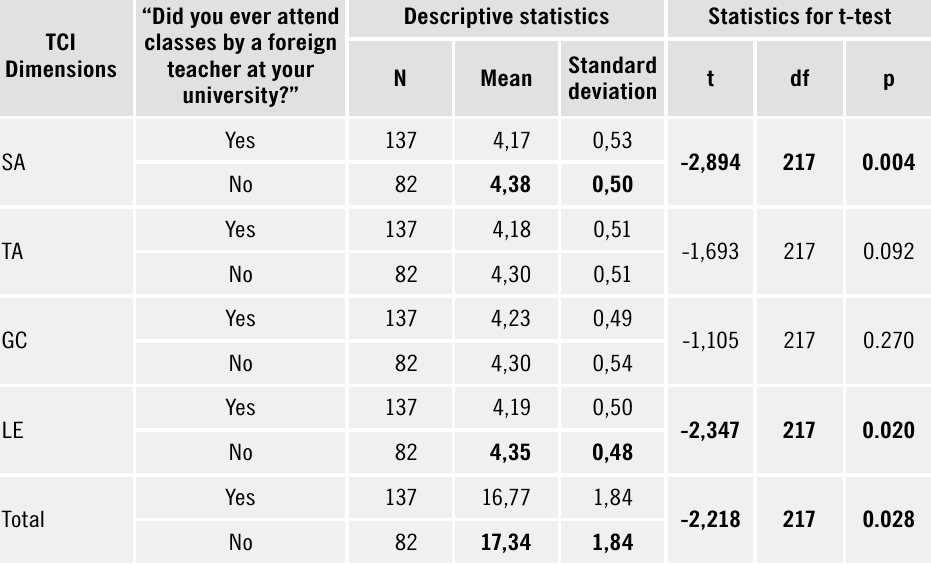
Table 4. Descriptive statistics and the t-test between respondents answering “Yes” or “No” to the question “Did you ever attend classes by a foreign